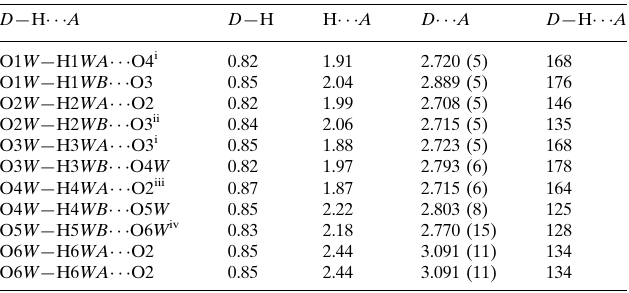
Hydrogen-bond geometry (A˚ , (cid:2) ). D —H (cid:1)(cid:1)(cid:1) A